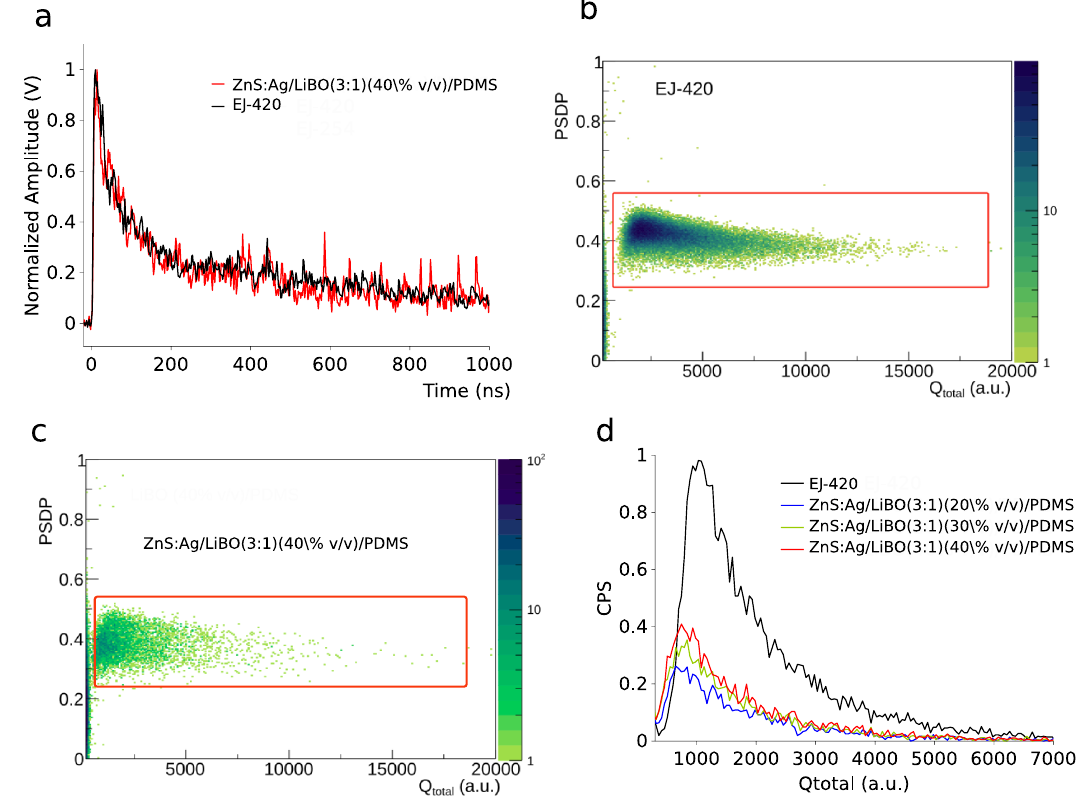
Figure 6. ( a ) Typical waveform of the detector tested. 2D-PSD plots corresponding to the measurements with the neutron flux at the CN accelerator with ( b ) the EJ-420 detector and ( c ) the ZnS:Ag/LiBO (3:1) (40% v/v)/ PDMS detector. ( d ) Energy spectrum of the detector tested with the 252 Cf